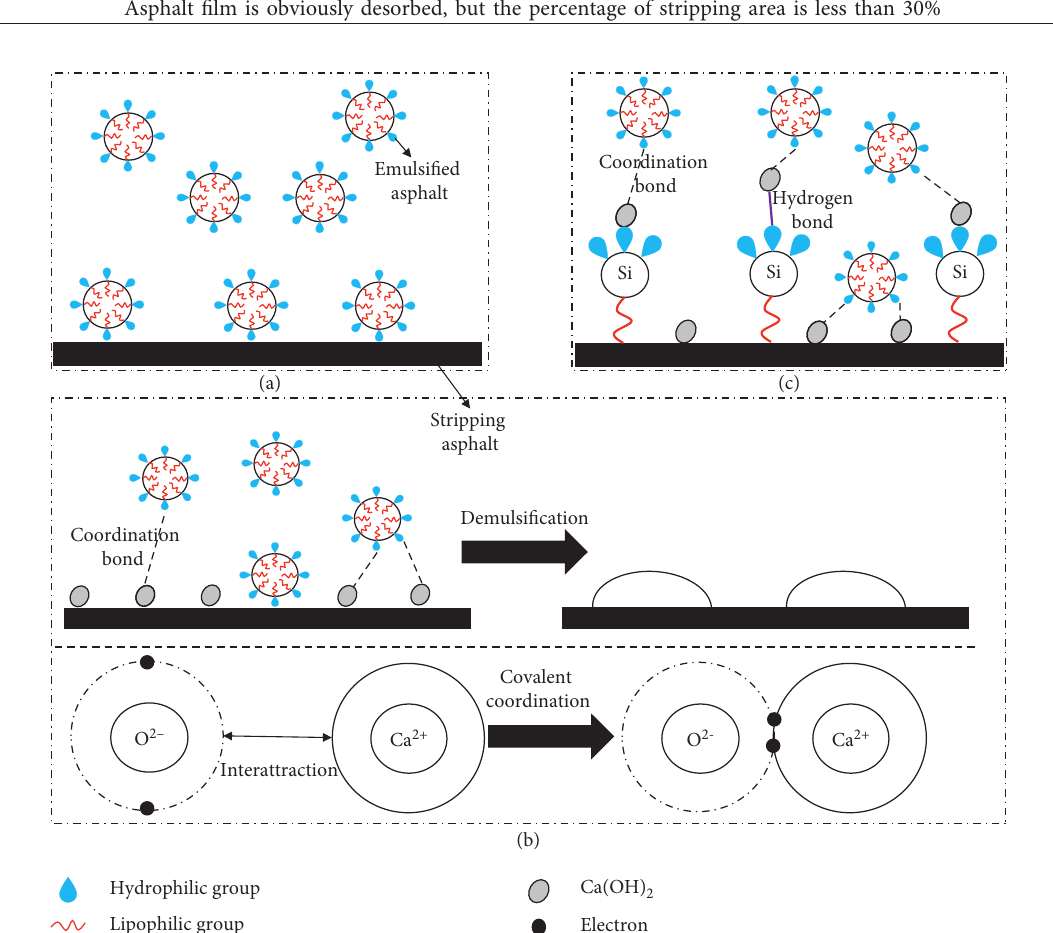
Figure 12: Diagram of adhesion between emulsified asphalt and RAP: (a) control, (b) S-Ca, and (c)